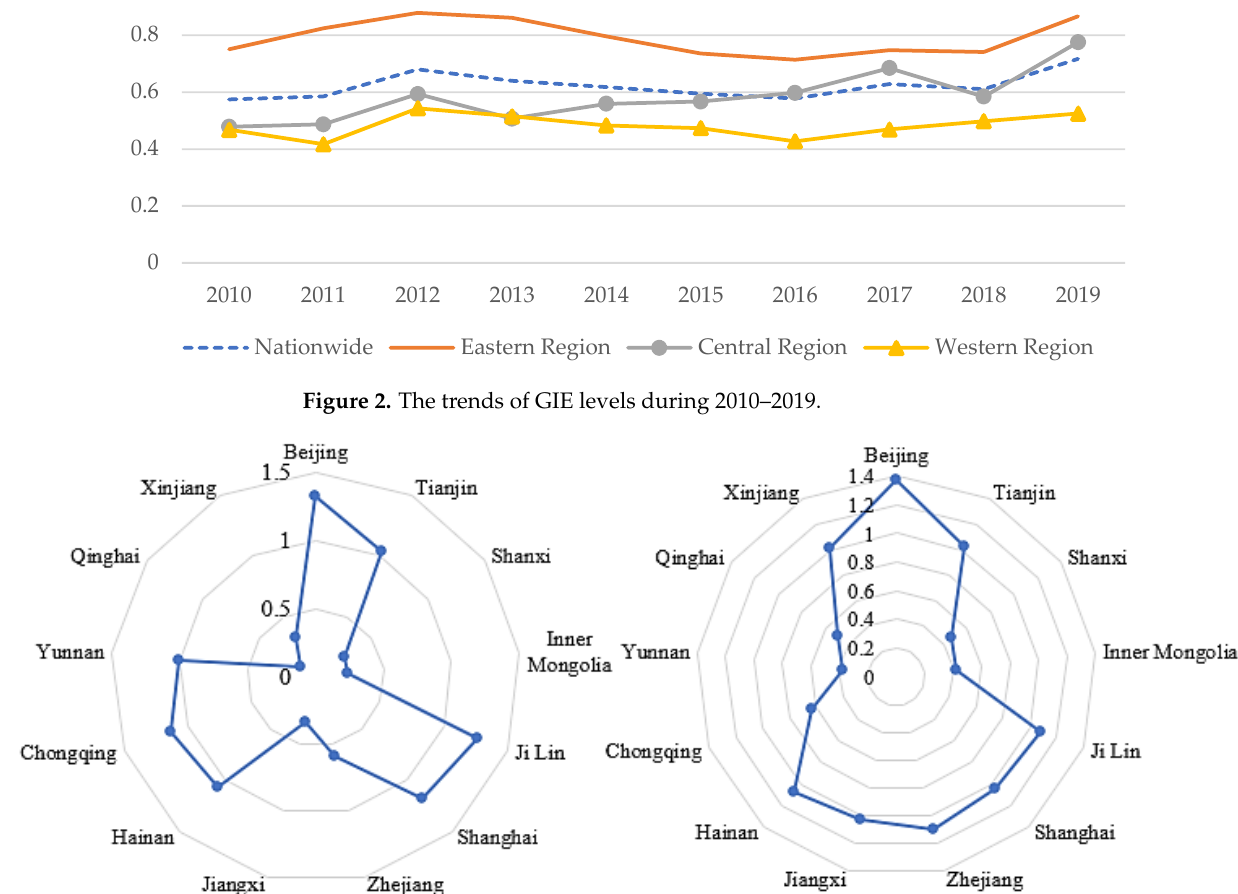
Figure 3. The GIE trends of selected provinces (autonomous regions and municipalities) in 2010 and 2019.